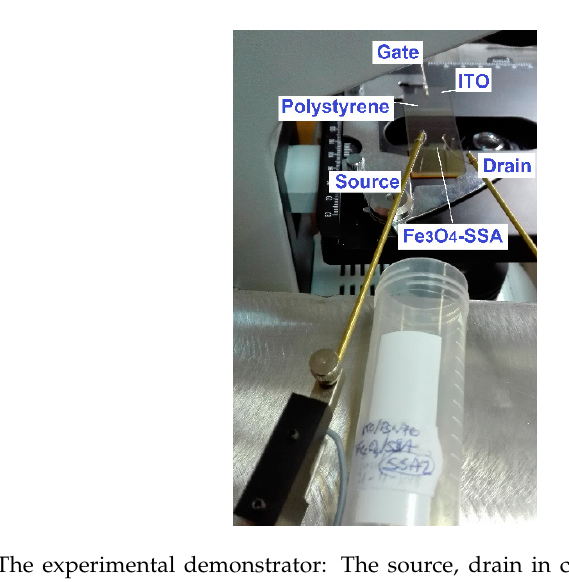
Figure 6. The experimental demonstrator: The source, drain in contact with te Fe 3 O 4 –SSA film (beige- colored), and gate connection to the ITO film. The colorless polystyrene film is longer than the Fe 3 O 4 – SSA film and is shorter than the ITO film, in agreement with Figure 5.